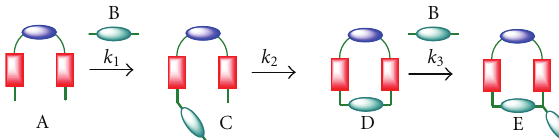
Scheme 4: Reaction of macrocycle D with dihalide B.